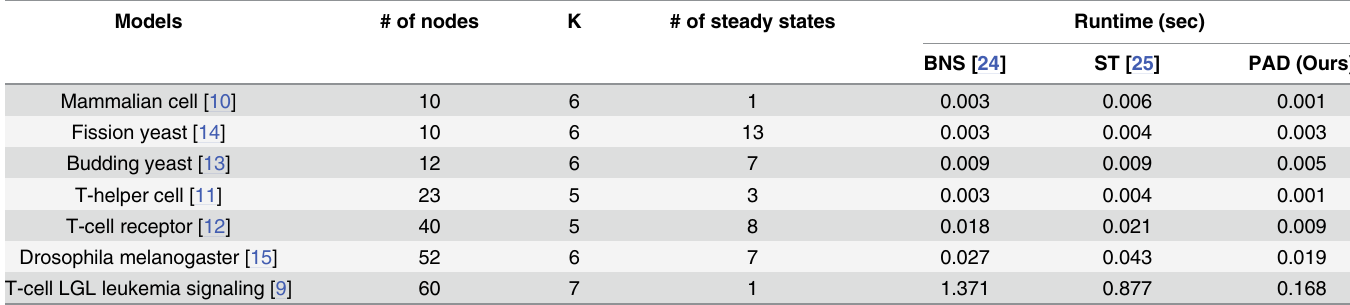
Table 1. Simulation results for detecting steady states from real Boolean networks.